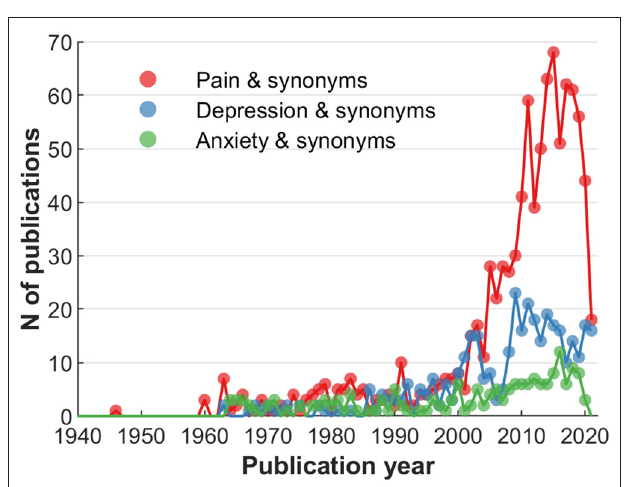
FIGURE 3 | Comparative frequency of articles by MeSH terms: Related to the investigated entity (e.g., clinical